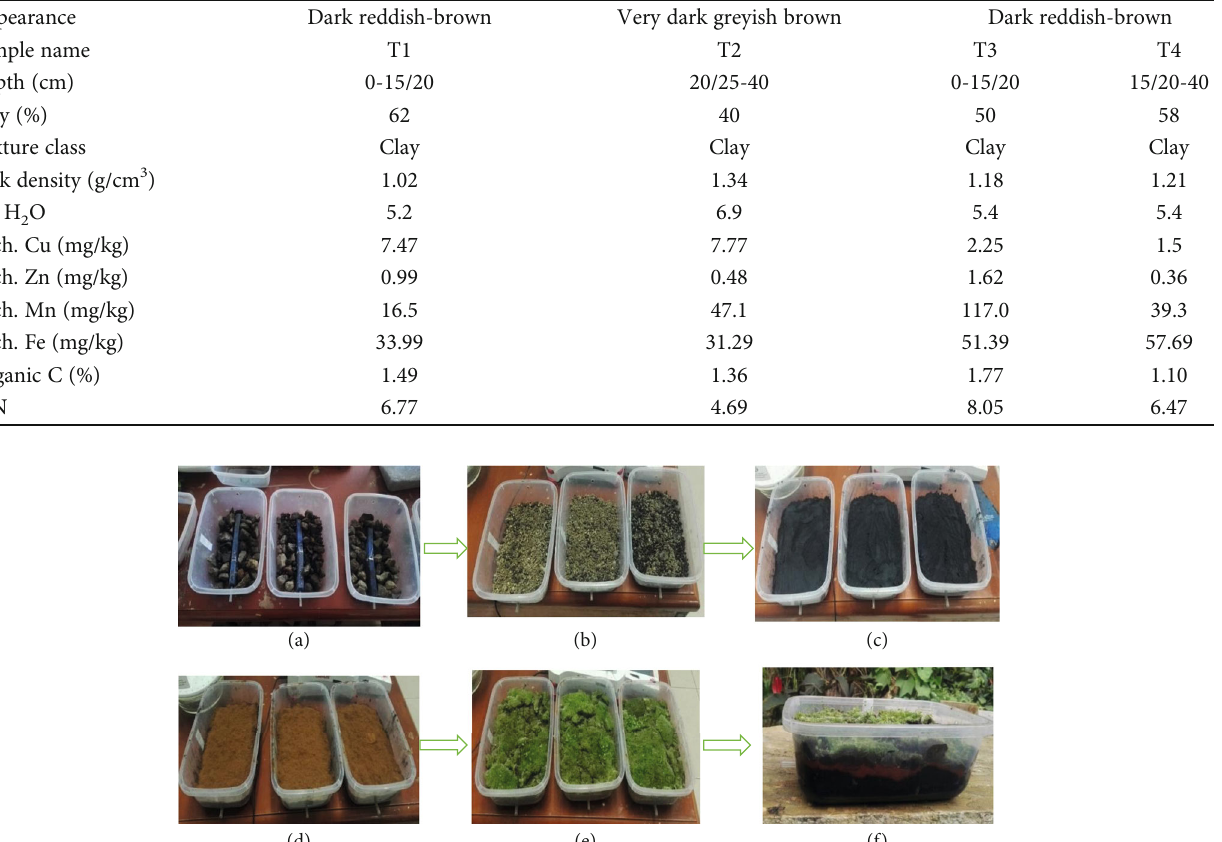
Figure 1: Preparation of the bio fi lter: (a) inlet through aeration; (b) gravel packs (200g); (c) biochar dust (250nm/100 g); (d) soil substrate (100g); (e) moss substrate (545g); (f) fi lter